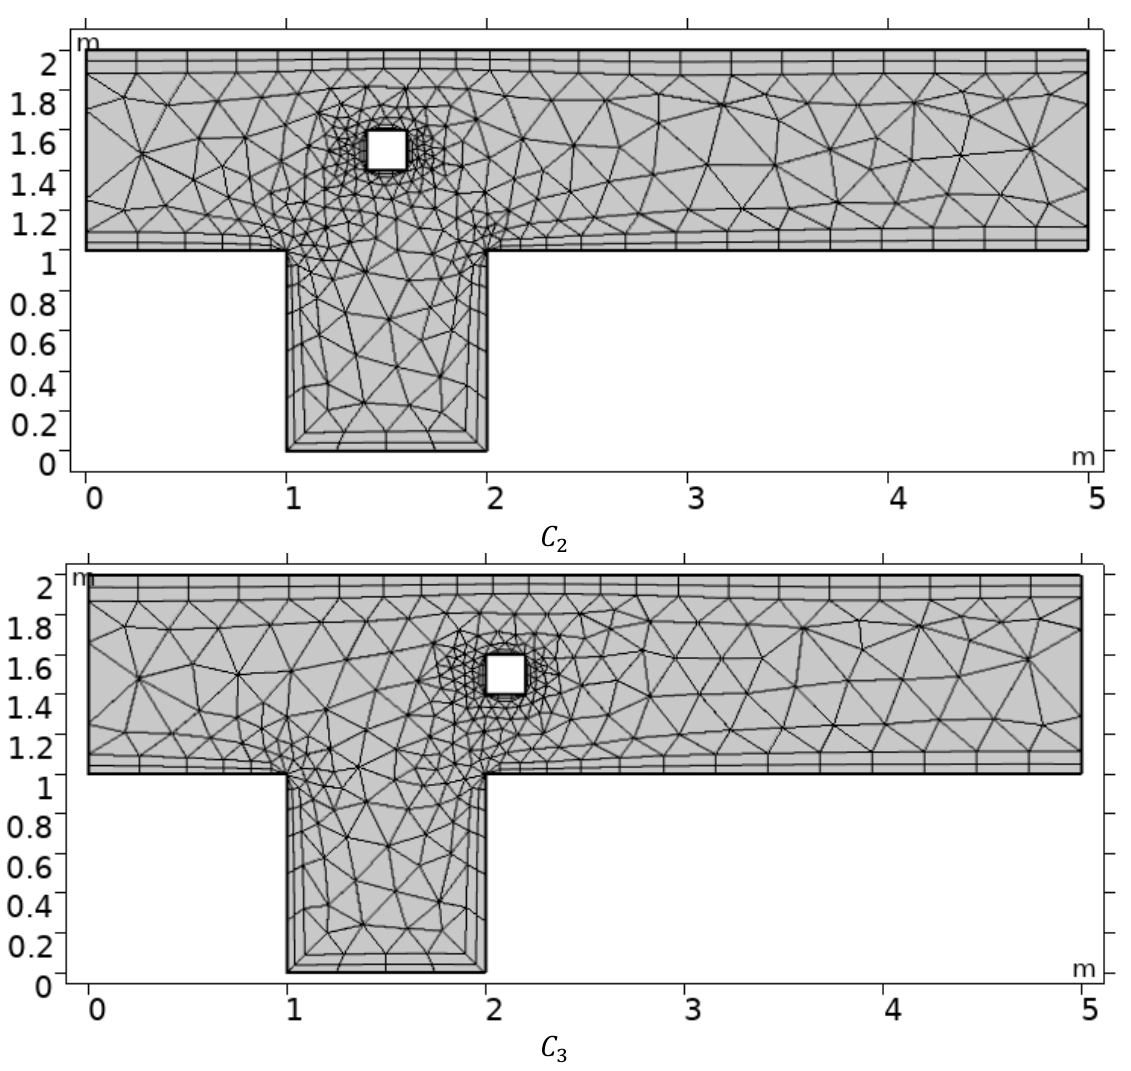
Figure 2. Computational coarse meshes for different positions of obstacle. Table 1. Number of Degrees of Freedom at Different Refinement Levels.